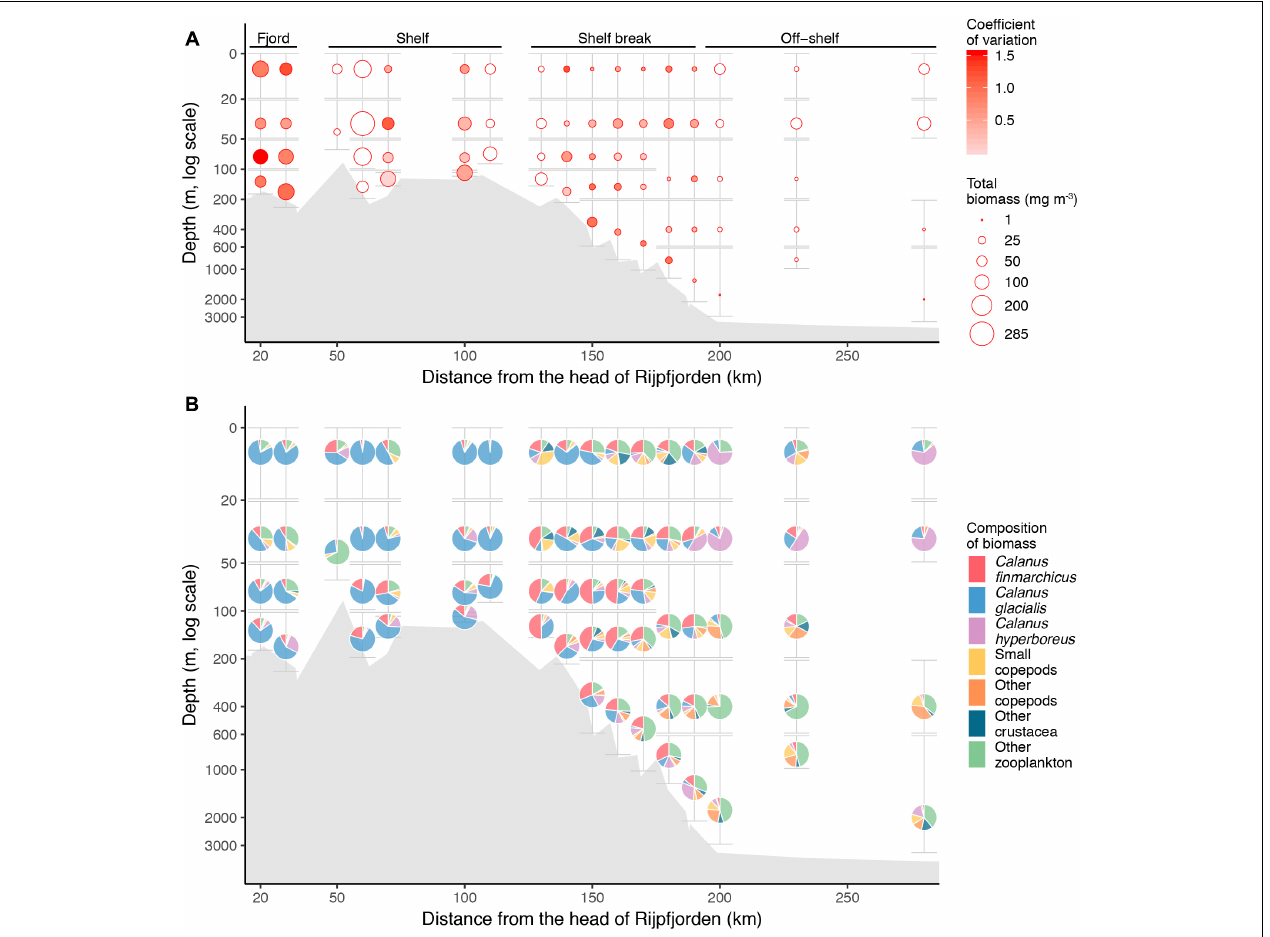
FIGURE 10 | Zooplankton distribution for data from all years combined. (A) Mean total mesozooplankton biomass (mg m − 3 ) and (B) average composition of main groups along the section from Rijpfjorden to the Arctic Ocean. The data are binned using a 10 km horizontal grid and the maximum and minimum vertical range of binned MultiNet samples. The radius of the dots in A is scaled to average biomass (mg m − 3 , legend giving the range of averages) and the fill is scaled to coefficient of variation. White fill indicates only one sample from a given location. The height of error bars indicate the maximum and minimum vertical range of binned MultiNet samples, while the width of the error bars indicates the width of horizontal binning. Empty space indicates that sample from that stratum was